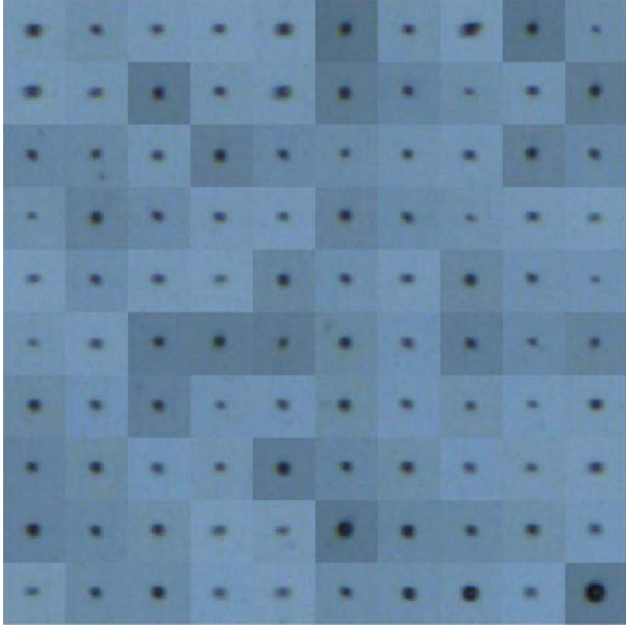
Fig. 8. Bubble image samples.